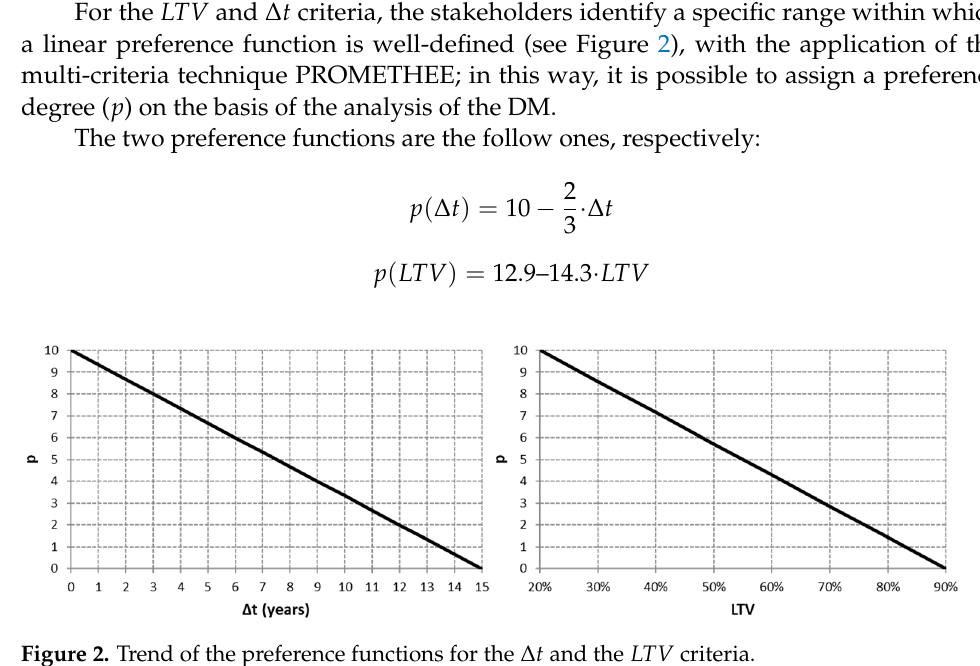
Table 5. Range and thresholds of the criteria. n.